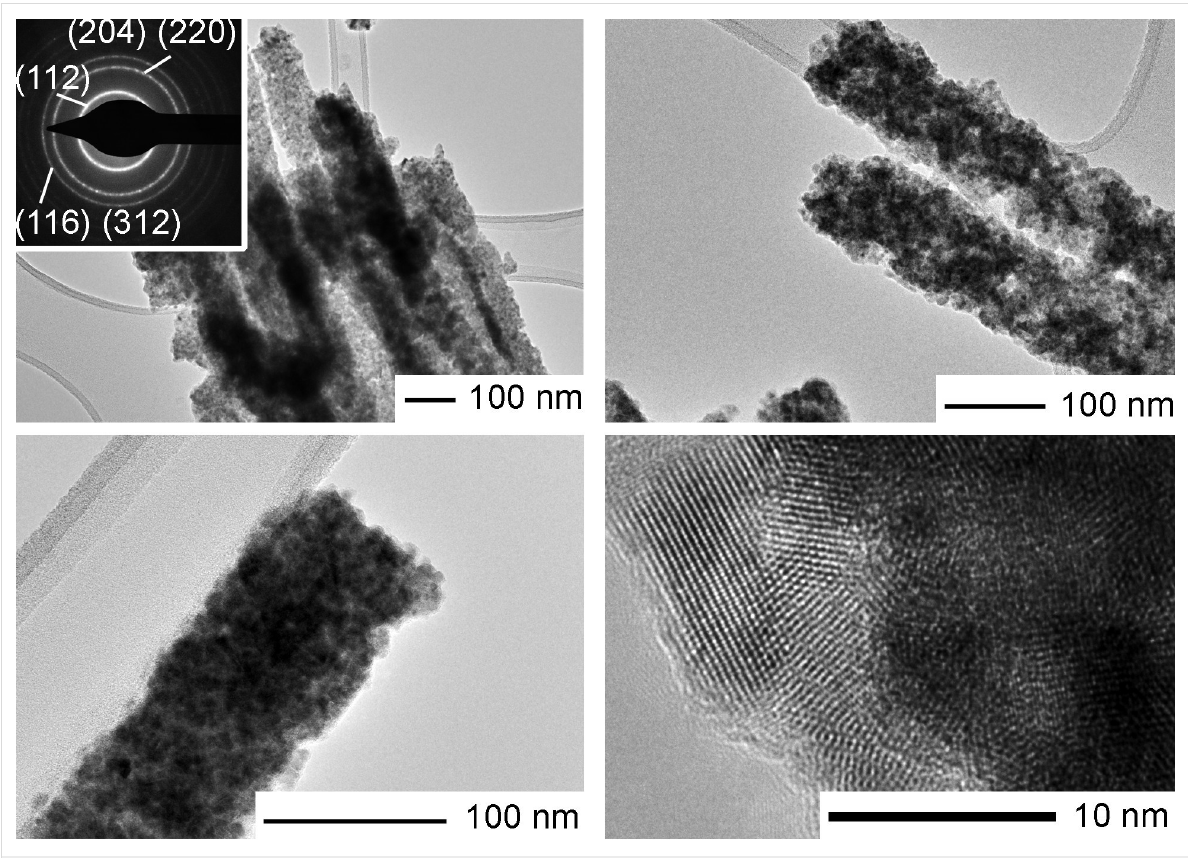
Figure 4: TEM images and SAED micrograph of polycrystalline CuInSe 2 nanorods.